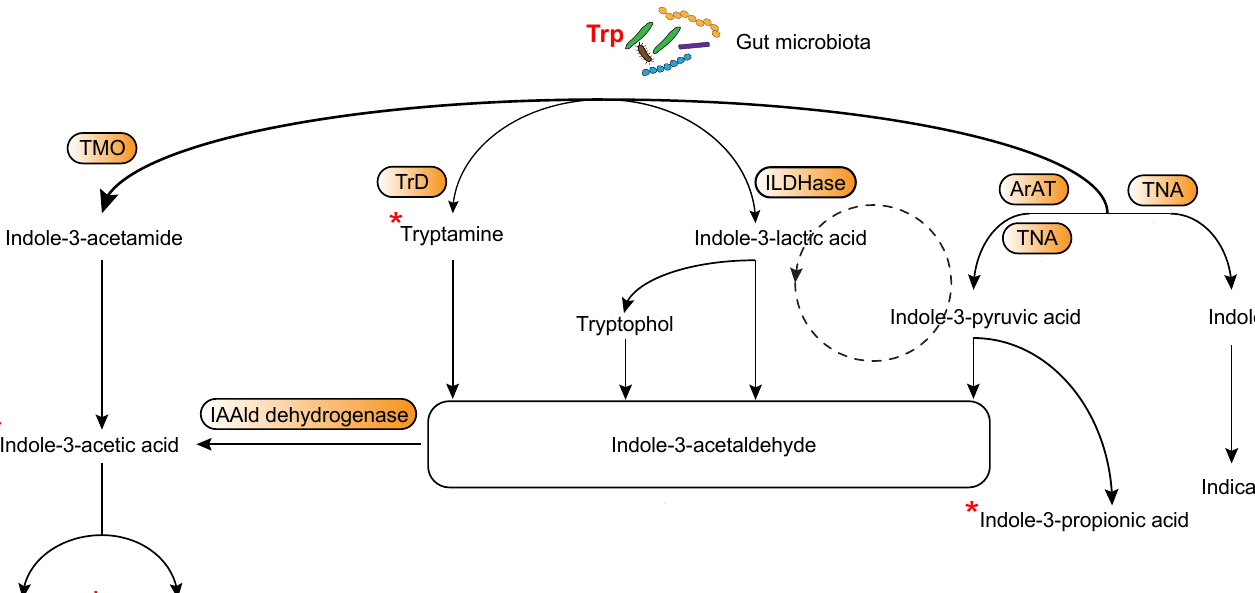
Figure 1. Main routes of tryptophan metabolism in microbiota. TMO, Tryptophan 2-monoxygenase, TrD, Tryptophan decarboxylase, ILDHase, Indole-3-lactic acid dehydrogenase, ArAT, Aromatic amino acid aminotransferases, TNA, Tryptophanase, IAAld (Indole-3-acetaldehyde) dehydrogenase. * Indicates known AhR ligands.